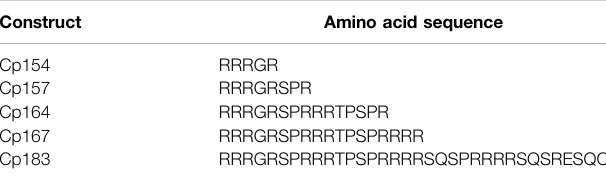
TABLE 1 | Amino acid sequences in one-letter code of arginine-rich nucleic acid binding regioninHBcAgVLP constructs. ResiduesarelocatedC-terminallyat the core domain with 149 amino acids (Crowther et al., 1994); HBcAg, hepatitis B core antigen; VLP, virus-like particle.